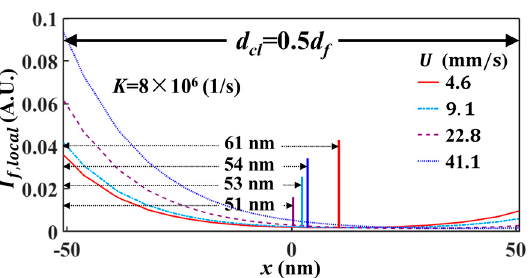
(cid:92) I f ,local ∼ x curves normalized at different